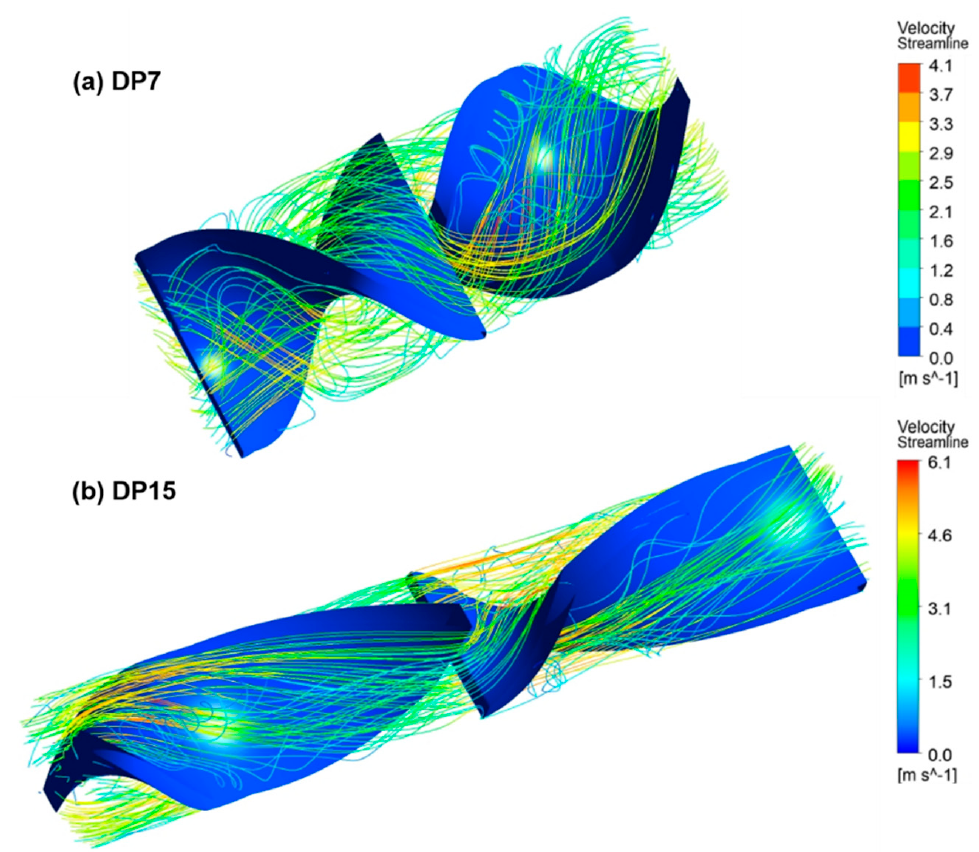
Figure 13. Streamline of the two adjacent elements combination for ( a ) DP7 and ( b ) DP15 .